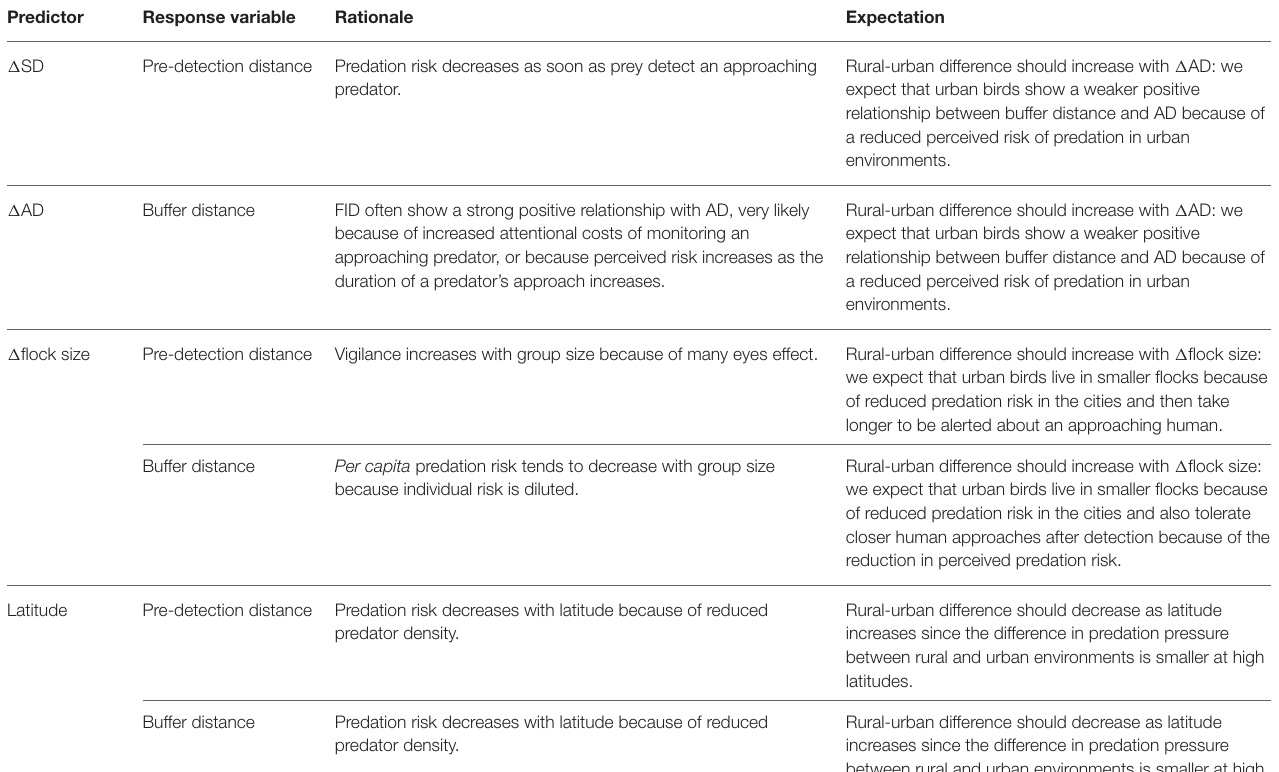
TABLE 1 | Hypotheses concerning predictors.